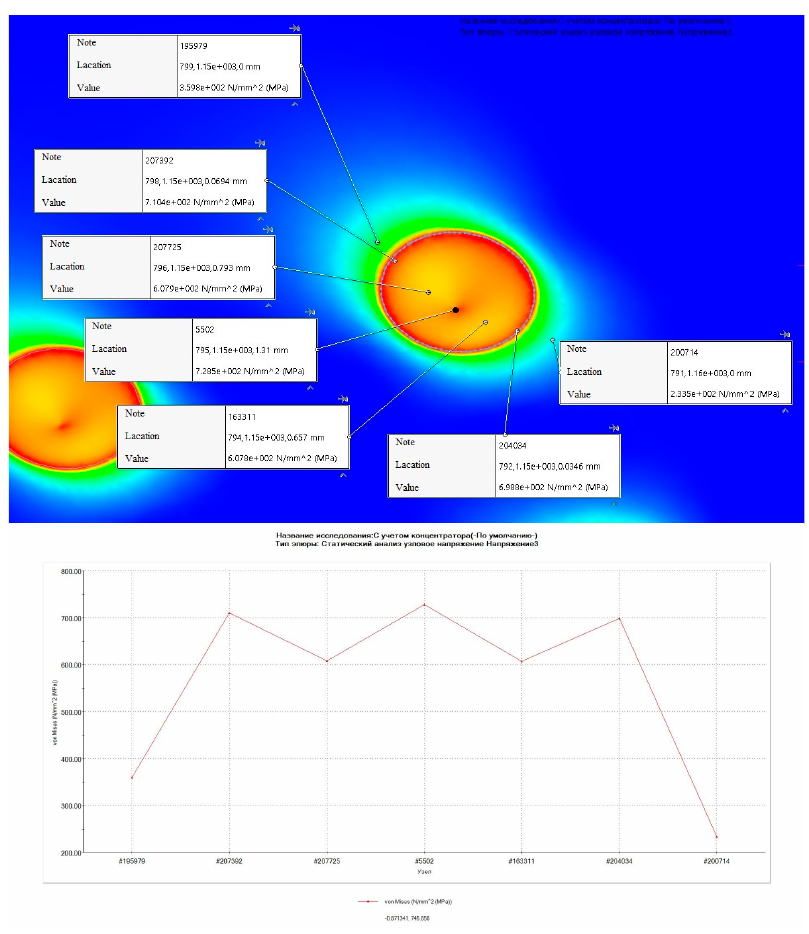
Figure 18. Change in stresses along the length of defect No. 3.